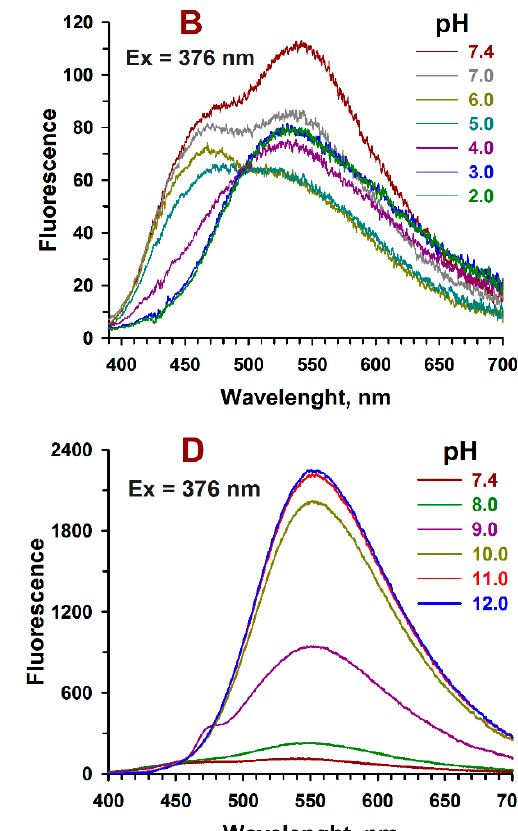
Figure 5. Fluorescence changes upon pH titration of the aqueous E -FCA solution (12.5 µM, 0.5% of ethanol). Fluorescence images of the aqueous E -FCA solution at various pH values under UV LED light (365 nm) ( A ); fluorescence changes upon neutral to acidic titration of E -FCA with 1 M aq. HCl under excitation at 376 nm ( B ); fluorescence changes upon neutral-to-alkaline titration of E -FCA with 1 M aq. NaOH under excitation at 420 nm ( C ) or 376 nm ( D ).